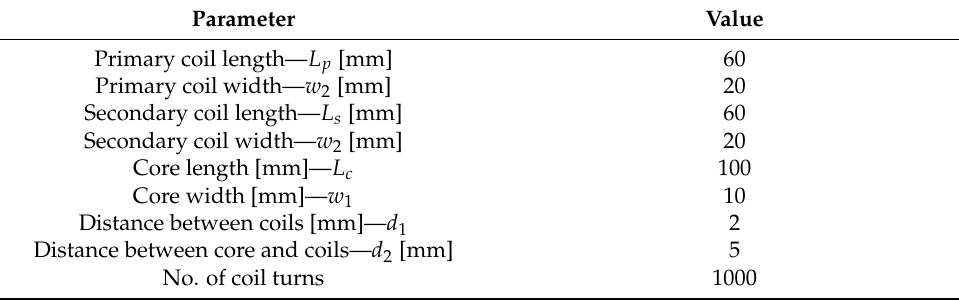
Table 1. Design parameters used for LVDT analysis.